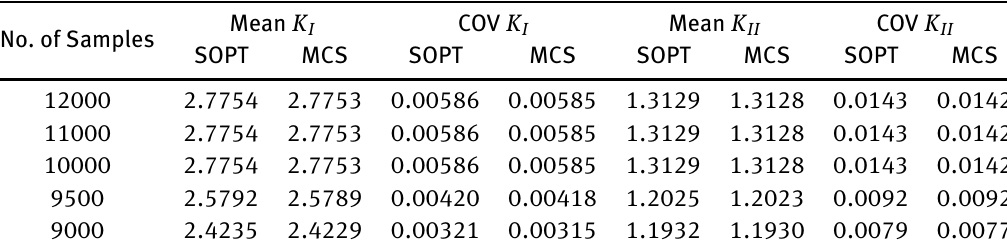
Table 5: Convergence study of number of samples used for MCS and comparison with FOPT results of SIFs K I and K II of single edge V- notched composite [0 ◦ /15 ◦ /15 ◦ /0 ◦ ]